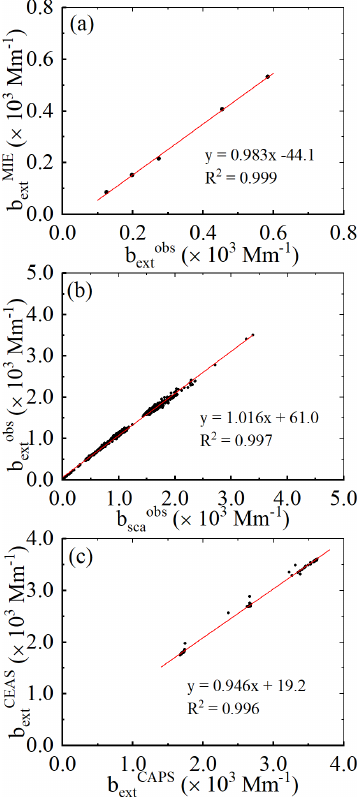
Figure 3. CAPS-ALB calibration results: (a) comparison of the measured and MIE-calculated extinction coefficient; (b) compari- son of the measured extinction and scattering coefficient; (c) com- parison between measured extinction coefficient of CAPS-ALB and